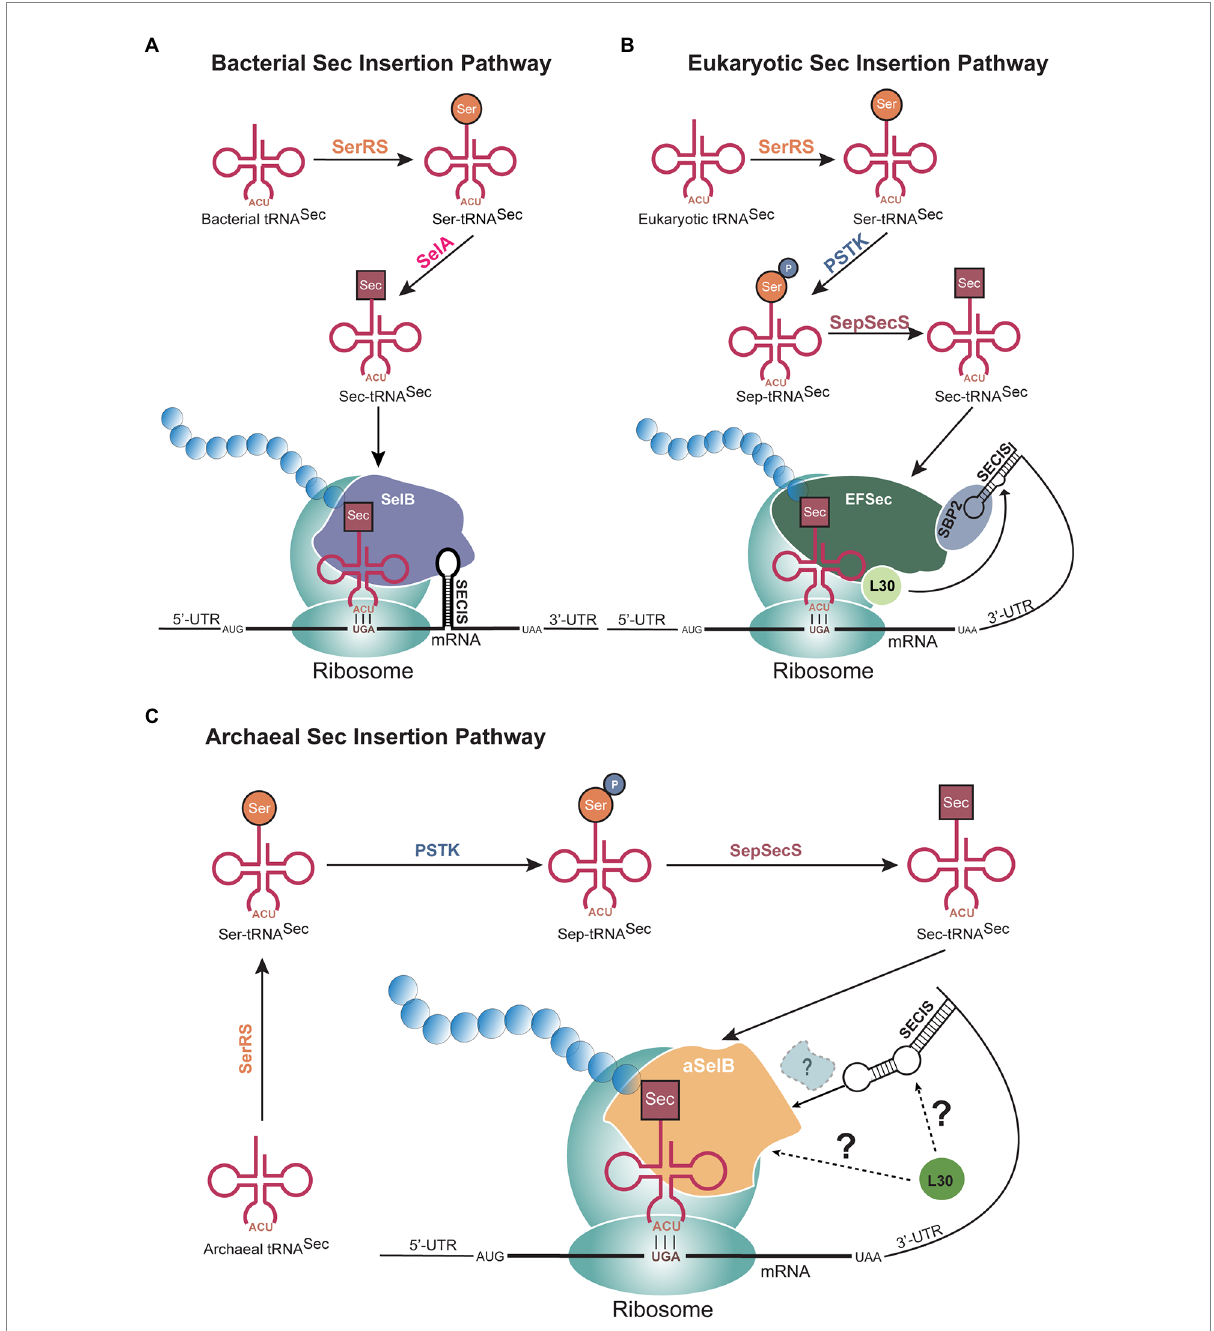
FIGURE 1 Selenocysteine (Sec) biosynthesis pathways in all domains of life. (A) In bacteria, the conversion of serine (Ser) to Sec occurs through a single step catalyzed by selenocysteine synthase (SelA), after tRNA Sec is aminoacylated by seryl-tRNA synthetase (SerRS). Sec is then incorporated at UGA codons with an immediate downstream selenocysteine insertion sequence (SECIS) element. In (B) eukaryotes and (C) archaea, two steps are needed to synthesize Sec from Ser, through the activity of phosphoseryl-tRNA Sec kinase (PSTK) and O -phosphoseryl-tRNA Sec :Sec synthase (SepSecS). The 3 ′ -untranslated region (UTR), which contains the SECIS element, bends to position the mRNA element closer to the UGA codon. The factors mediating this recruitment are not fully known in archaea and eukaryotes. In all three domains, a Sec-specific elongation factor (SelB in bacteria, aSelB in archaea, and EFSec in eukaryotes) functions to bring Sec-tRNA Sec to the